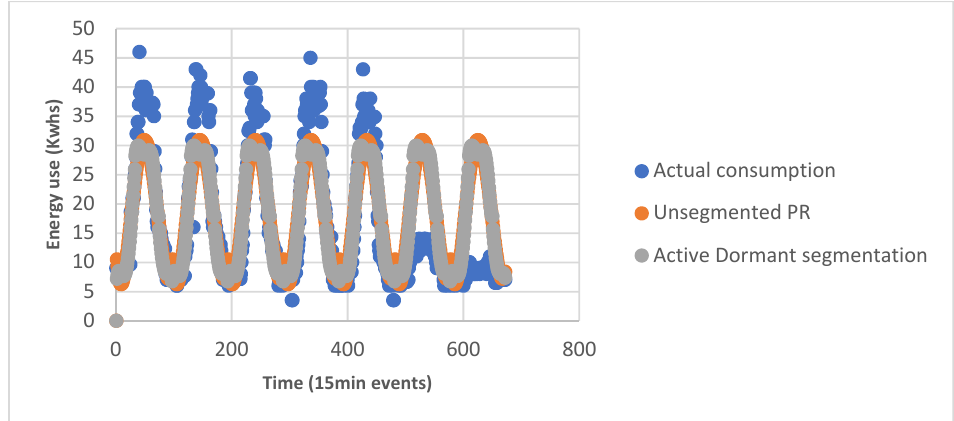
Figure A7. A comparison of building active and dormancy period segmented weekly PR prediction, to actual consumption and the unsegmented predicted consumption, in the first week of autumn.